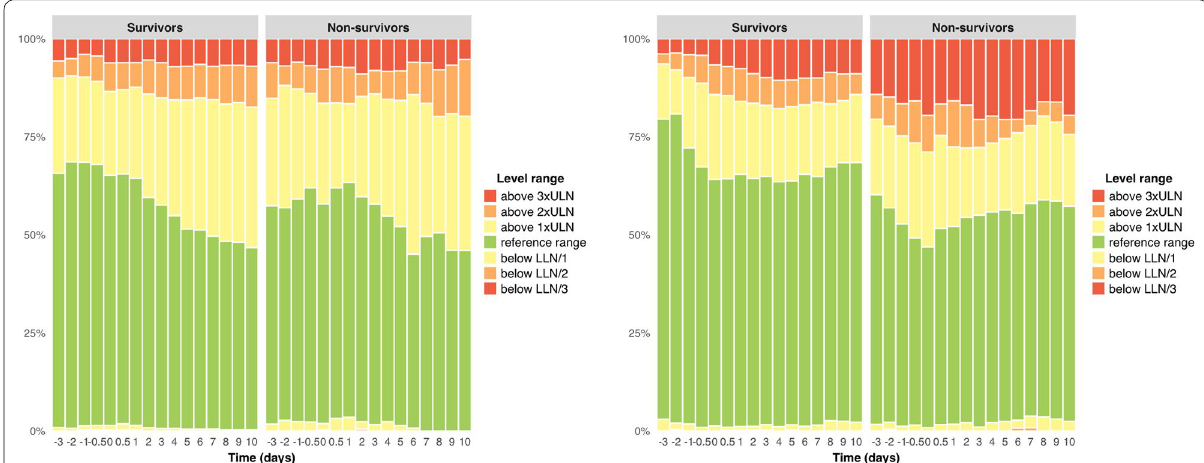
Fig. 4 a AP level range over time; b bilirubin level range over time. Evolution of the proportion of survivors and non-survivors with alkaline phos- phatase (left) and bilirubin (right) levels within and outside the reference range. T-ASTmax is designated as time 0. AP alkaline phosphatase, LLN lower limit of normal, ULN upper limit of